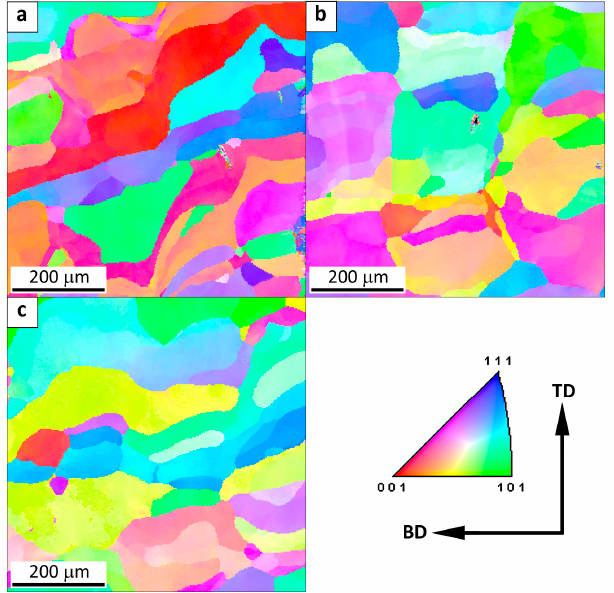
Figure 4. The map of crystallographic orientation in a sample obtained at a low cooling rate: ( a ) at the substrate (0.7 × 10 4 K/s), ( b ) half the height of the sample (0.6 × 10 4 K/s) and ( c ) top of the sample (0.6 × 10 4 K/s). The spatial orientation of the sample is presented with respect to the building direction (BD) and transverse direction (TD).